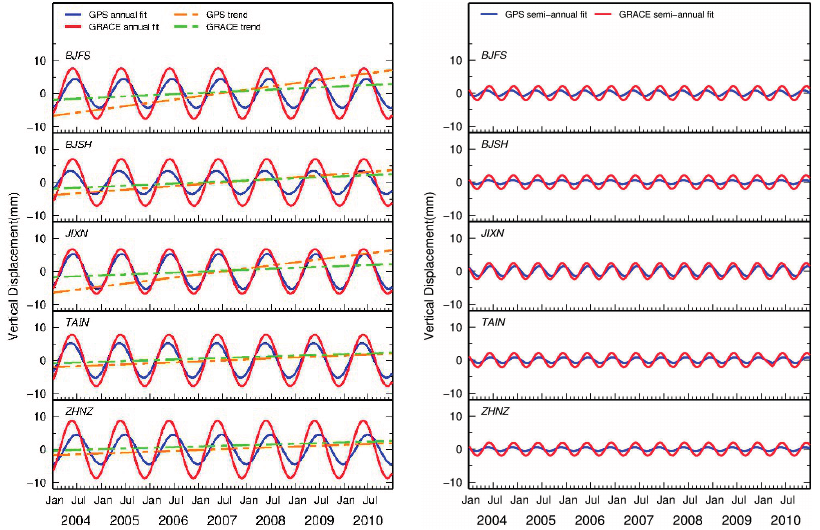
Figure 6. GPS- and GRACE-derived trends, annual and semi-annual signals between 2004 and